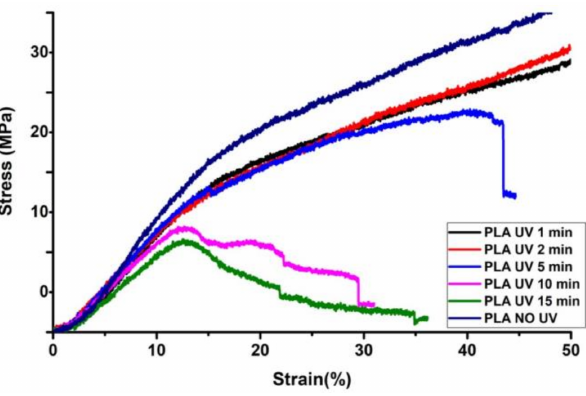
Figure 7. Radial compressive stress–strain curve before and after UV